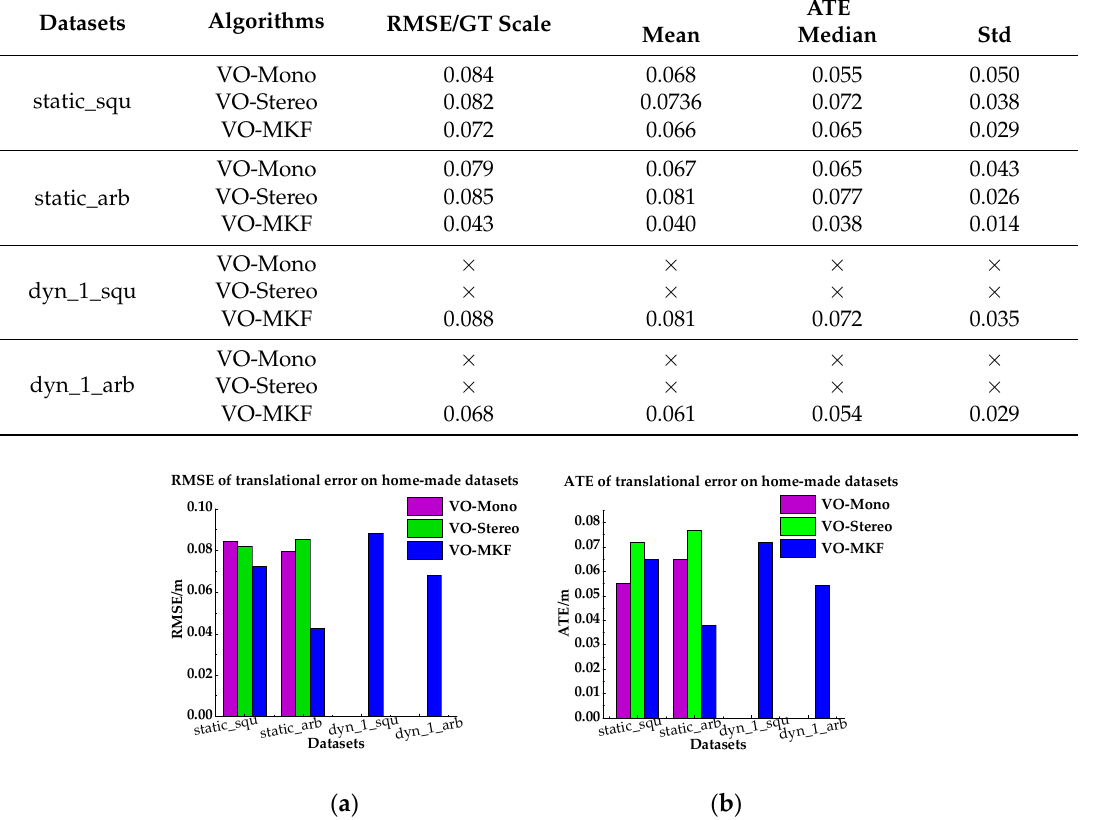
Table 2. The root mean square error (RMSE/m) and absolute trajectory error (ATE/m) results of VO-Mono, VO-Stereo and VO-MKF on home-made datasets.